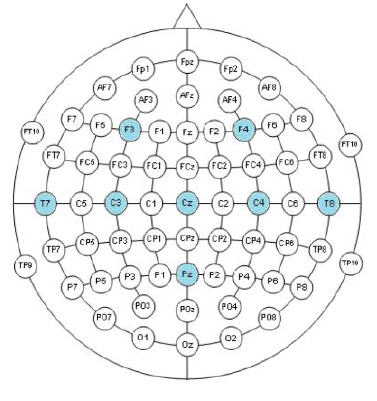
Figure 4. Registered EEG channels.